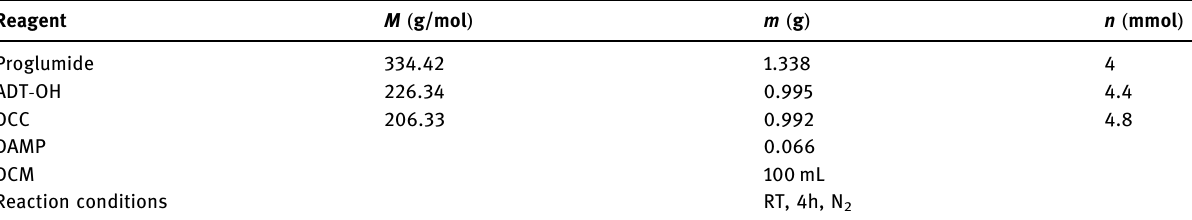
Table A2: Synthesis of P - A